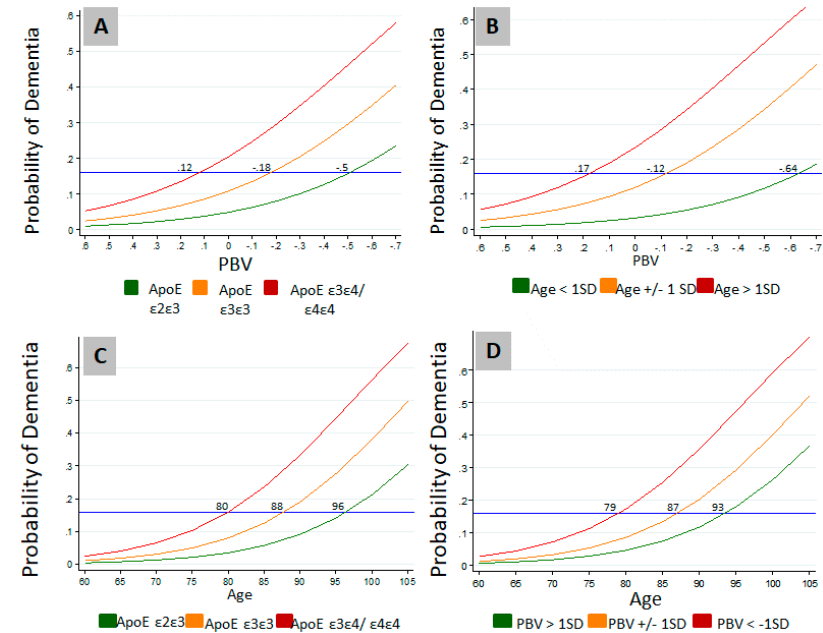
Figure 2. Effects of age and APOE genotype on the probability of dementia is modulated Figure 2. E ff ects of age and APOE genotype on the probability of dementia is modulated by PBV. ( A ) Modulation of the e ff ect of genotype on the probability of dementia by PBV; ( B ) E ff ects of age by PBV. ( A ) Modulation of the effect of genotype on the probability of dementia by PBV; distribution on the probability of dementia at di ff erent PBV levels; ( C ) E ff ects of genotype on the ( B ) Effects of age distribution on the probability of dementia at different PBV levels; ( C ) probability of dementia at di ff erent ages; ( D ) E ff ects of PBV distribution on the probability of dementia at di ff erent ages. Logistic regression was carried out to determine the e ff ects of PBV, age, and APOE genotype on the probability of dementia in the study cohort. PBV: Plasmalogen Biosynthesis Value; SD: Standard